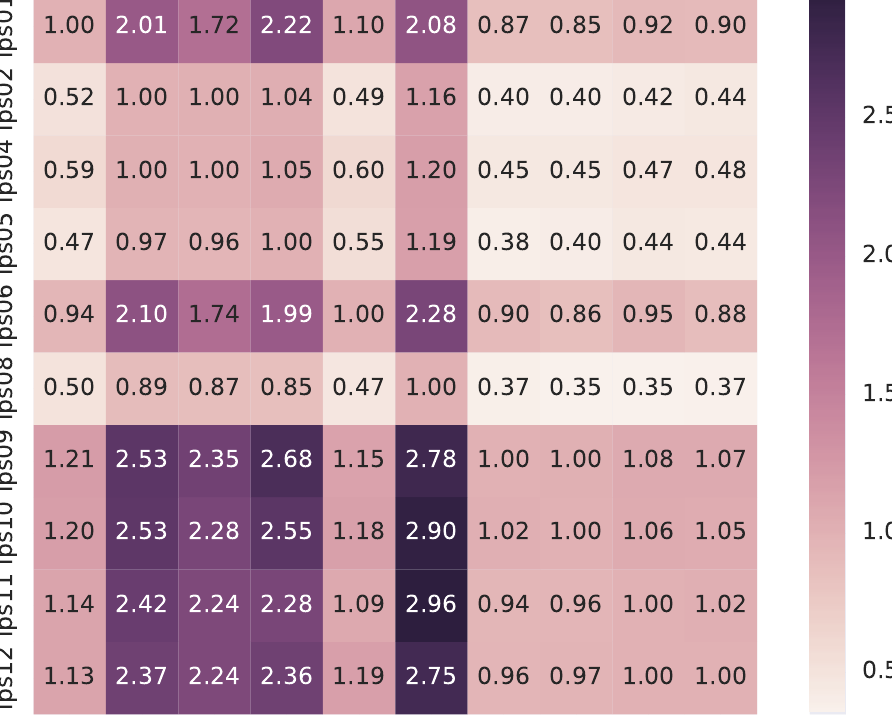
Figure 5. DTE Task Parallelism performance comparison between different computing nodes to highlight cluster heterogeneity. In Task Parallelism, each experiment spawned number of channels ∗ ( number of channels − 1 ) DTE tasks of the same size across computing nodes, their execution times were used to calculate quickening of the y -axis computing node over the x -axis computing node and finally an average of calculated speedups for each cell was made. An execution log used to generate this plot was from 20 surrogates. Values are given in relative